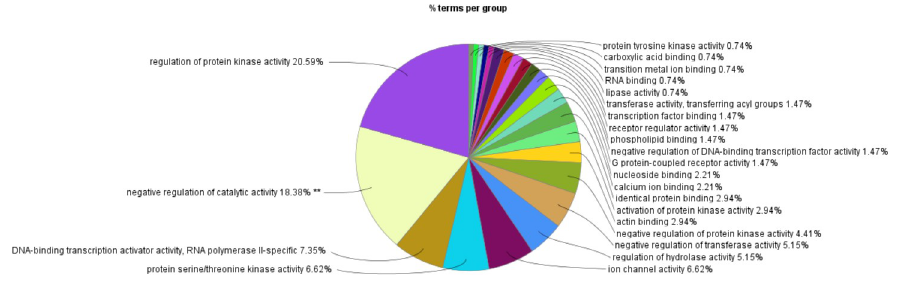
Fig 8. GO-molecular function. �� P <